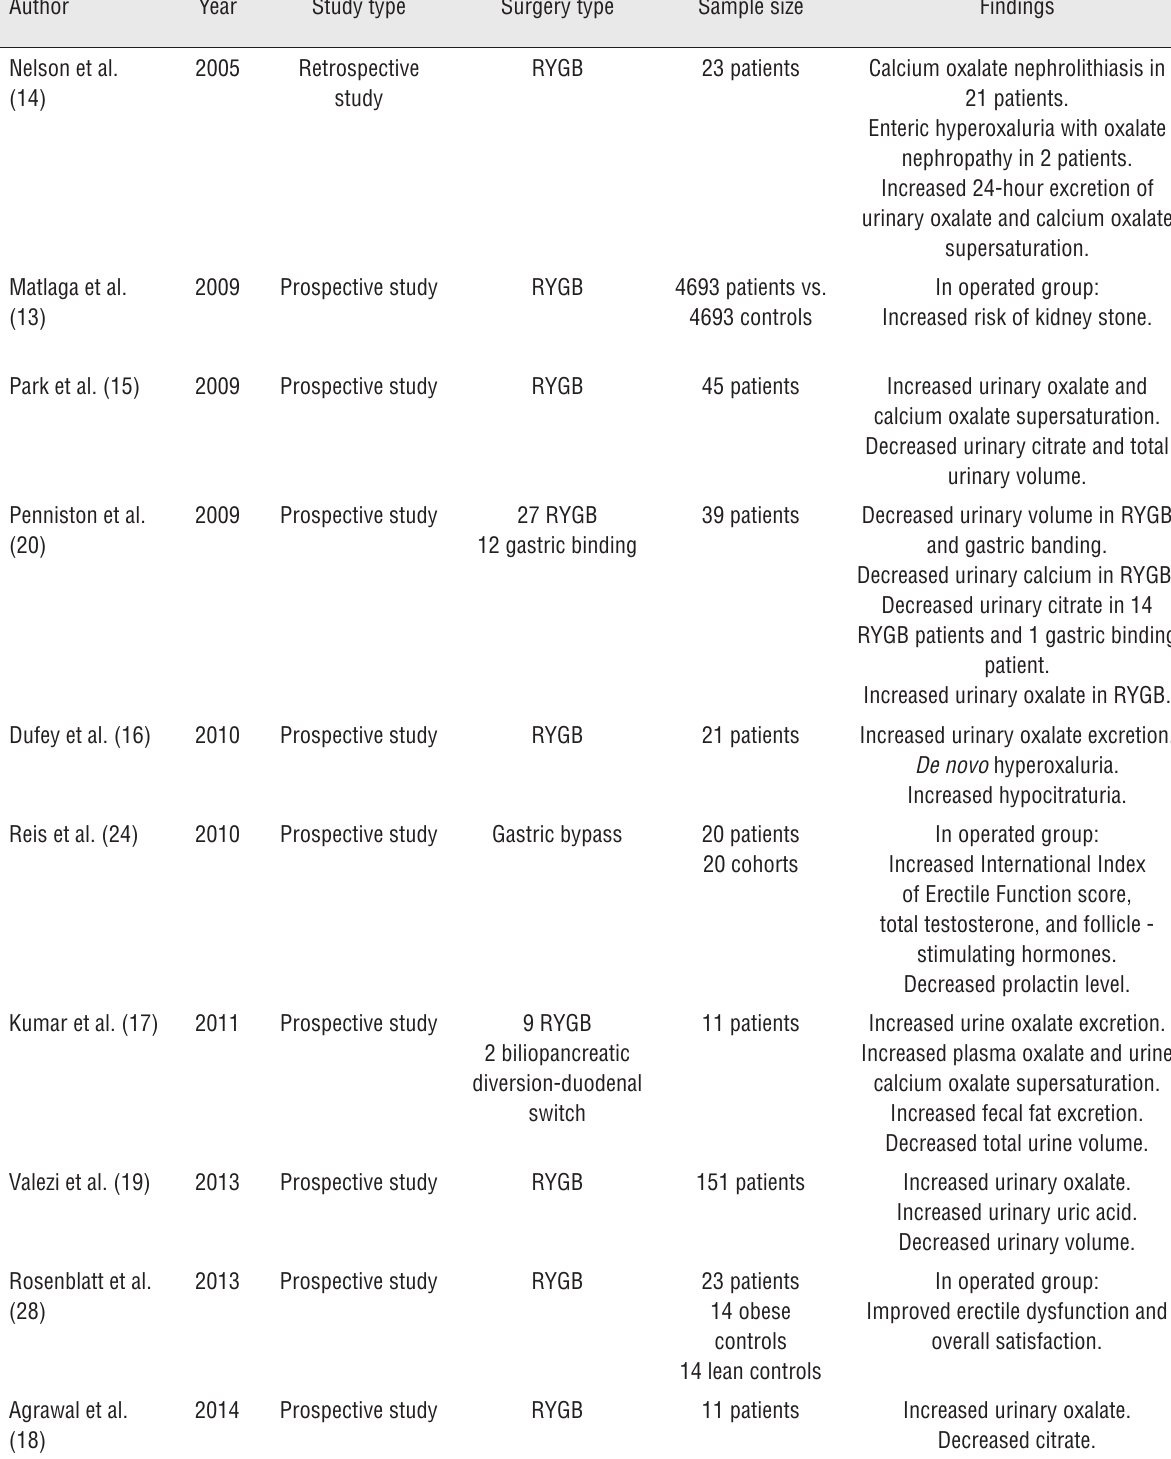
Table 1 - Human studies about physiological alterations of bariatric surgery on the genitourinary system arranged by study